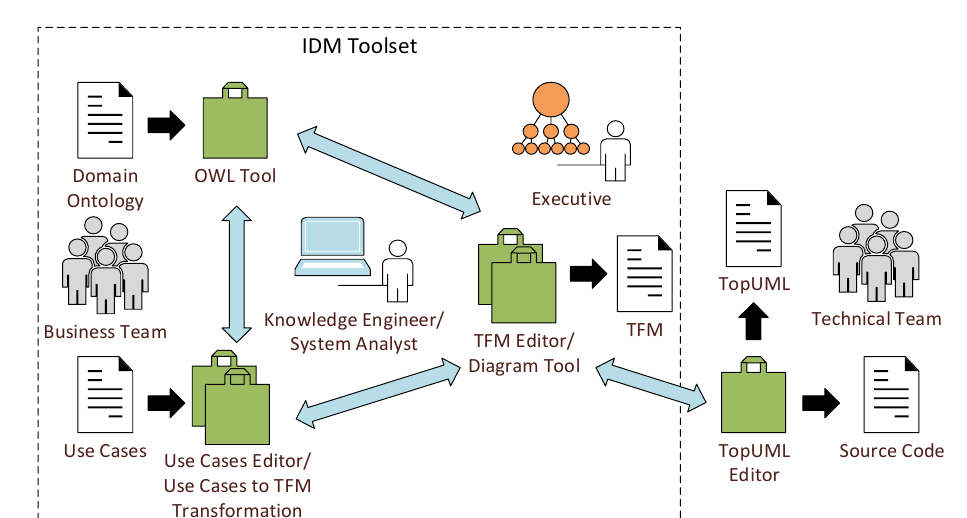
Fig. 1. TFM toolset components and artifacts. Here the planned toolset is shown with the involved people within a business environment to support the full TFM process within MDA life cycle. IDM toolset is a subset of this toolset ( dotted rectangle ), which includes OWL tool, Use Case Editor/Use Cases to TFM Transformation and TFM Editor/Diagram